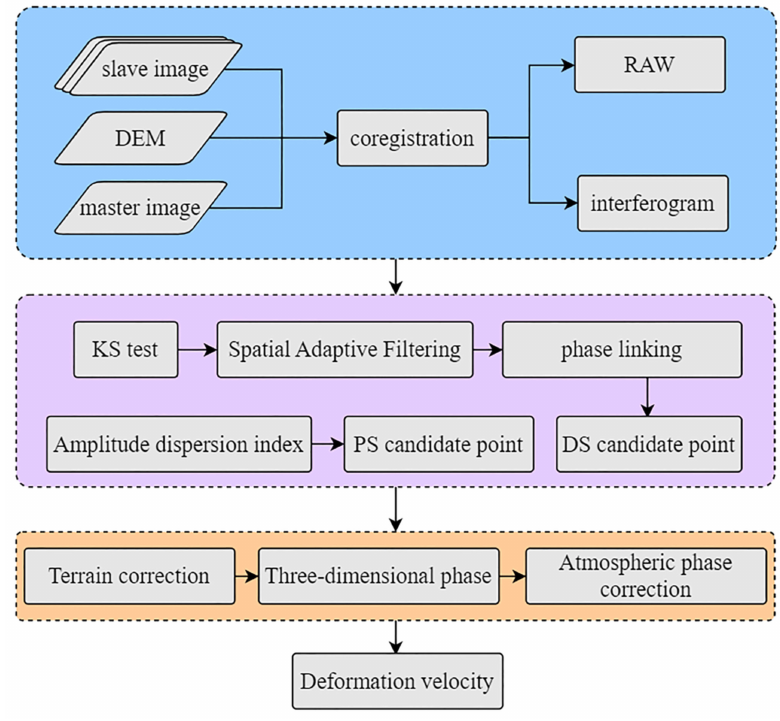
Figure 8. SqueeSAR data processing